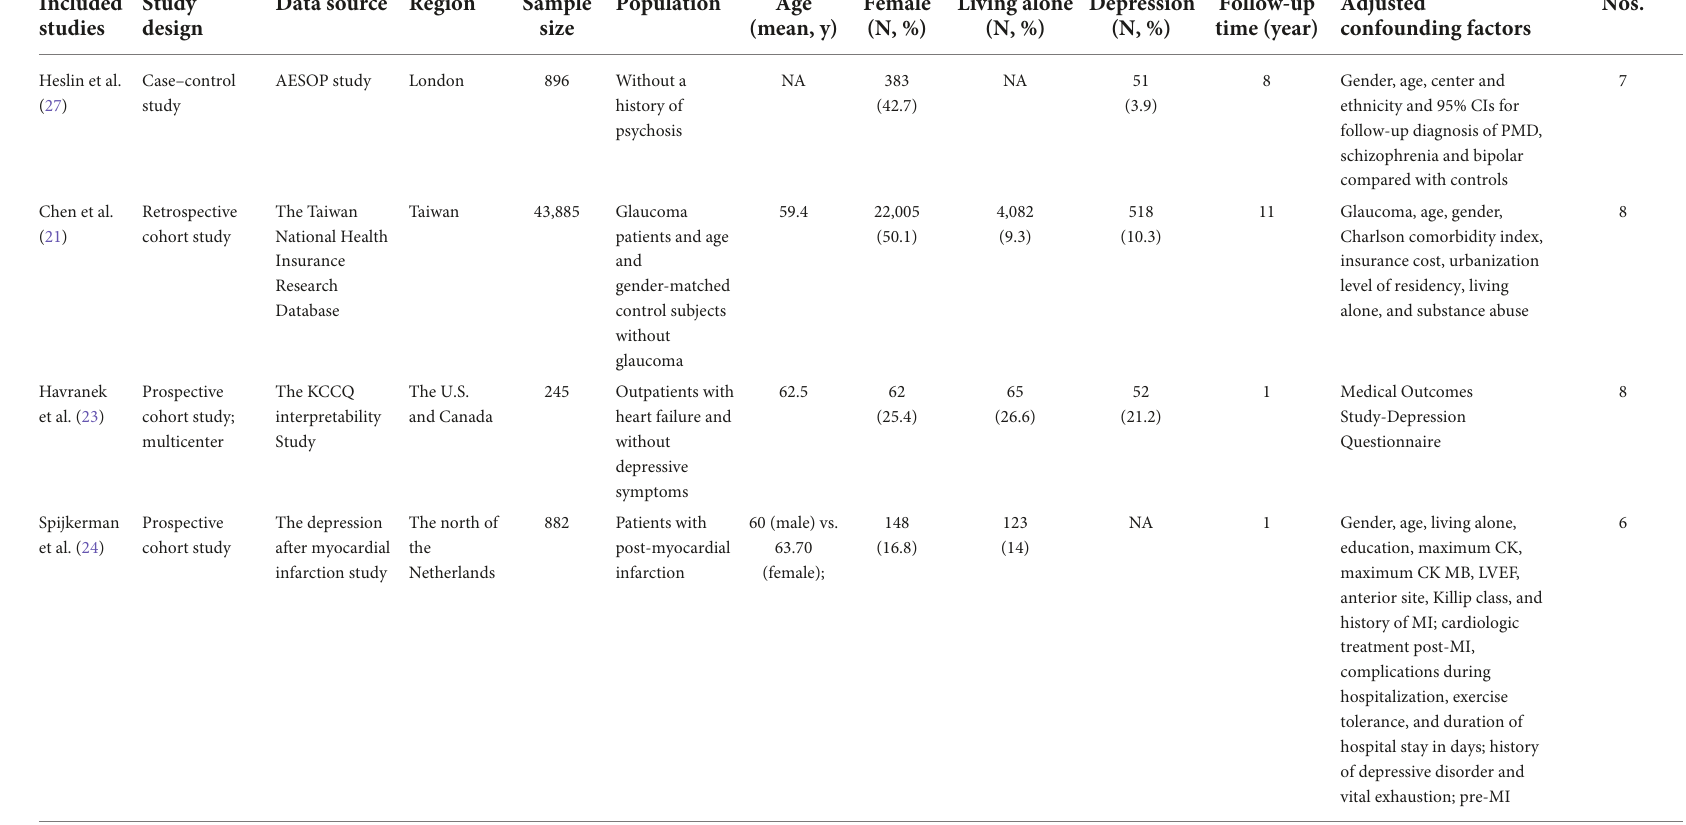
TABLE 1 Baseline patient characteristics of the included studies.